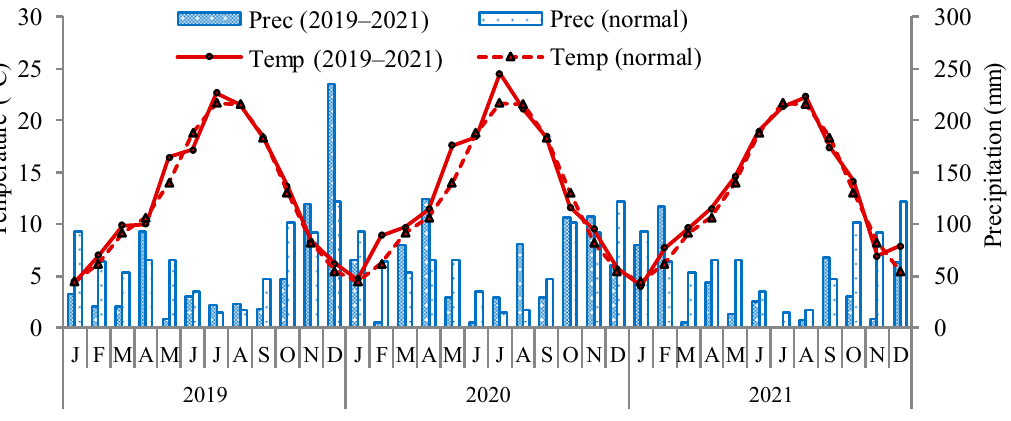
Figure 1. Average monthly temperatures (Temp) and accumulated precipitation (Prec) during the experimental period and values of the climatological normal from the meteorological station of Bragança.